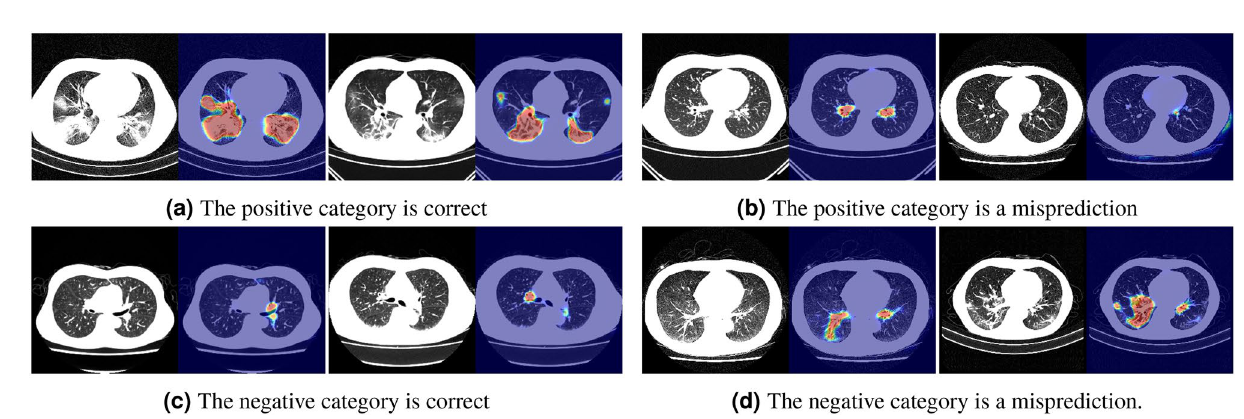
Figure 7. Results of visual explanations for binary classification. ( a , c ) Results when predictions are correct. ( b , d ) Results when predictions are